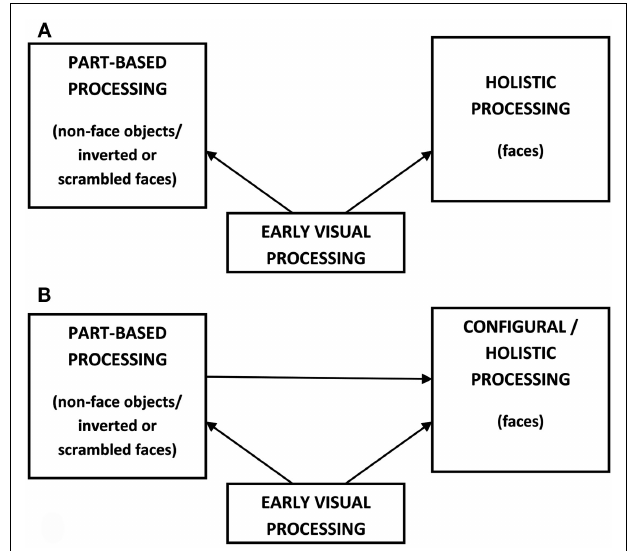
FIGURE 2 |Two different models of holistic processing. (A) A face perception model adapted from Farah (1996). Object and face perception are independent of one another. Faces are perceived as undifferentiated wholes while objects are processed on the basis of their individual parts. (B) A holistic/part-based model of face perception. Holistic/configural and part-based processing work in parallel, making separate contributions to face perception that can be assessed independently of one